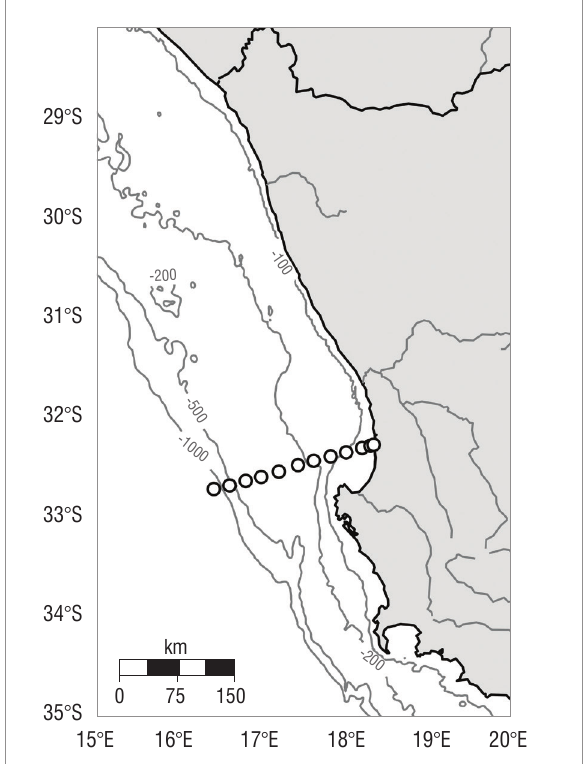
Figure 1: A map of the study region. The southern Benguela extends from 30°S to 35°S with the 500-m isobaths marking the offshore boundary. The markers show the location of the 12 stations where samples were taken.